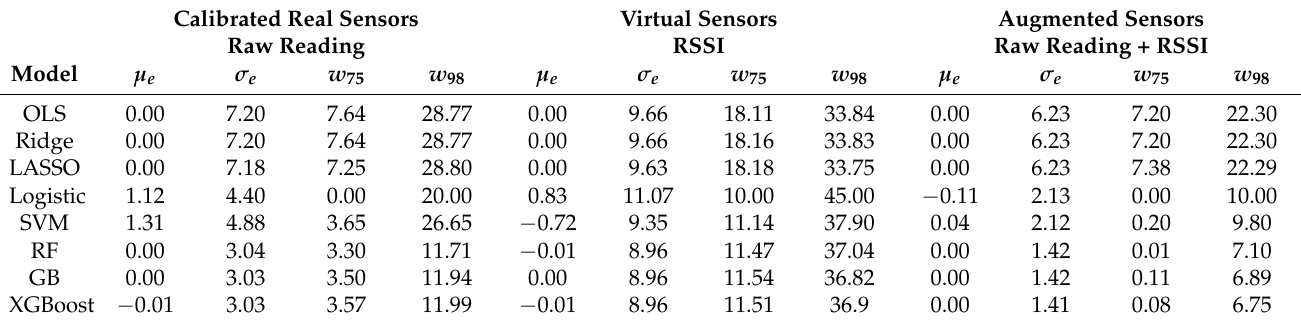
Table 2. Performances of analysed ML models for the training set. µ e is the mean estimation error, σ e the root mean square estimation error, w 75 and w 98 are the width of the VWC intervals containing, respectively, 75% and 98% of the estimation errors. The first set of columns presents the performances of the model versions grounded on raw readings only (i.e., the calibrated real sensors). The second set of columns presents the performances of the model versions relying on RSSIs only (i.e., the virtual sensors). Finally, the last set of columns presents the performances of the model versions accounting for both raw readings and RSSIs (i.e., the augmented